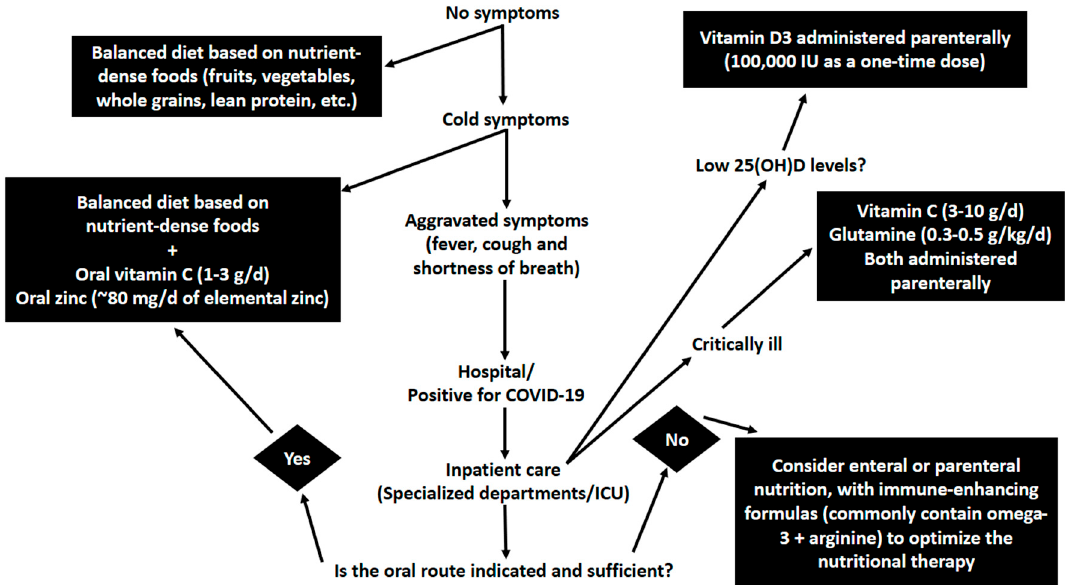
Figure 1. Possible adjunct pharmaconutrition in the management of COVID-19. All pharmaconutrition strategies displayed in this diagram should be considered in conjunction with established medical care guidelines. Additionally, such proposed roles are based on non-COVID-19 research and reflect the authors’ interpretation of potentially relevant literature. Interventions should ideally be further assessed in clinical trial and cautiously administered under close medical care.